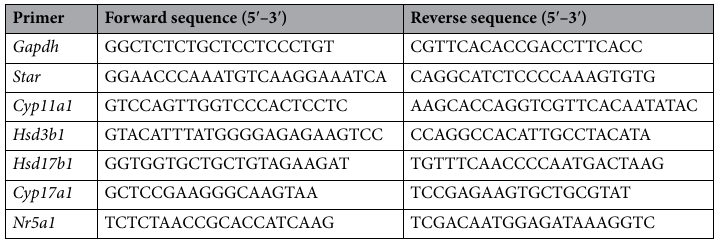
Table 1. The primer